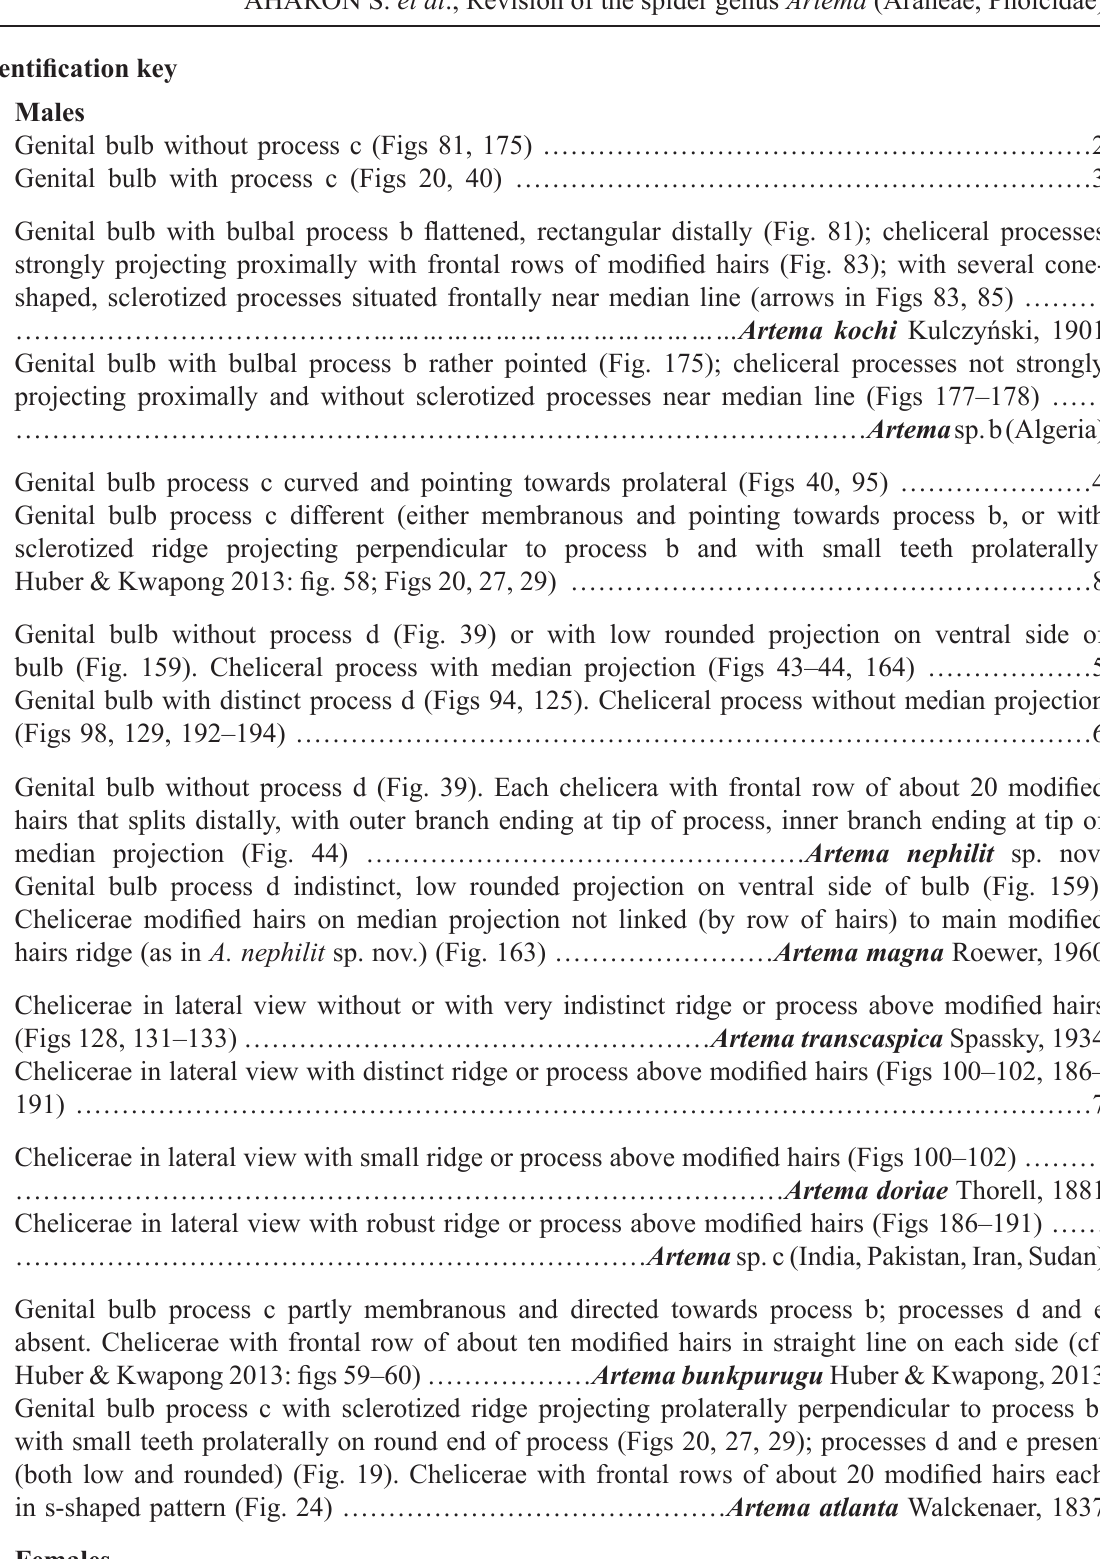
Females 1. Anterior epigynal projections (AEP) sclerotized and elongated (Fig. 86); epigynal plate wide rectangular, with triangular anterior projection between AEP …… Artema kochi Kulczyński, 1901 – Anterior epigynal projections (AEP) not or only weakly sclerotized and not elongated; epigynal plate